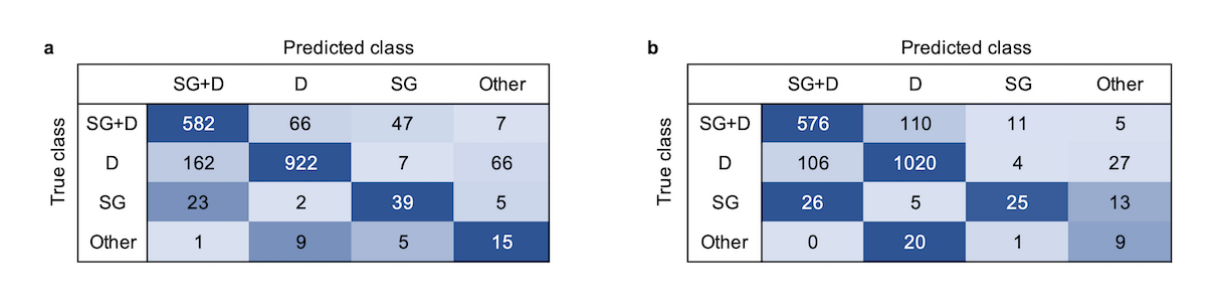
Figure 5. (a) Classifier and (b) human coder confusion matrices for semi-inclusive layout. D: Dialogue; SG: Screen Gaze; SG+D: Screen Gaze +